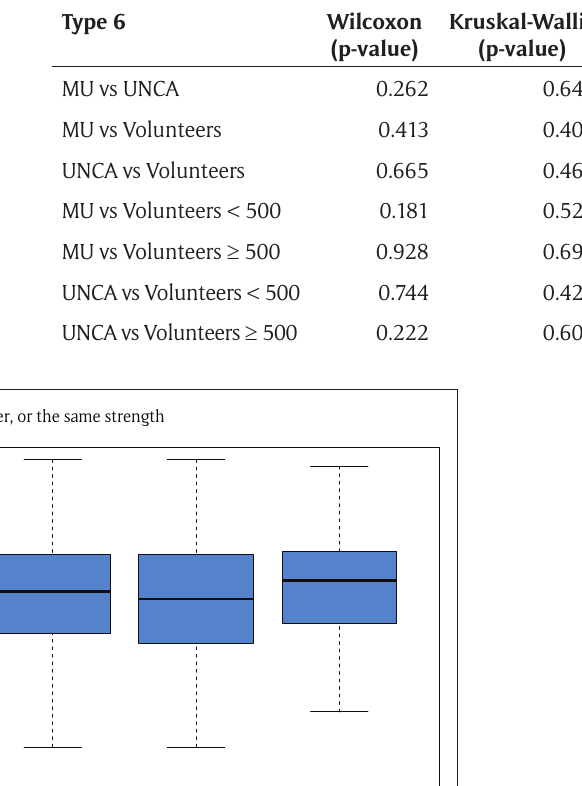
Table 5: Wilcoxon and Kruskal Wallis test results for Type 6 (cyclone type assignment). Values significant at